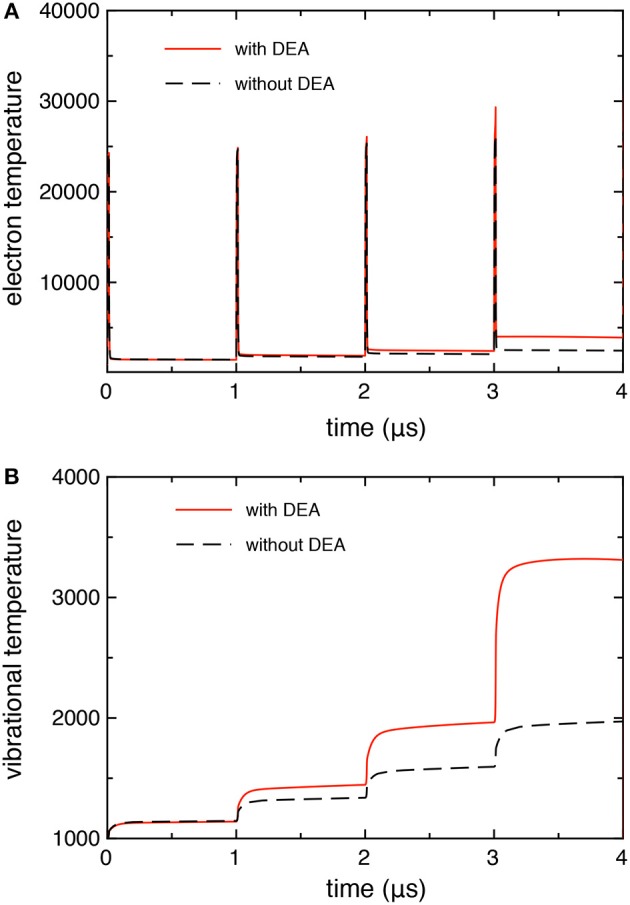
(A) Electron, and (B) vibrational temperature as a function of time, calculated with and without DEA processes (tid = 1 μs).